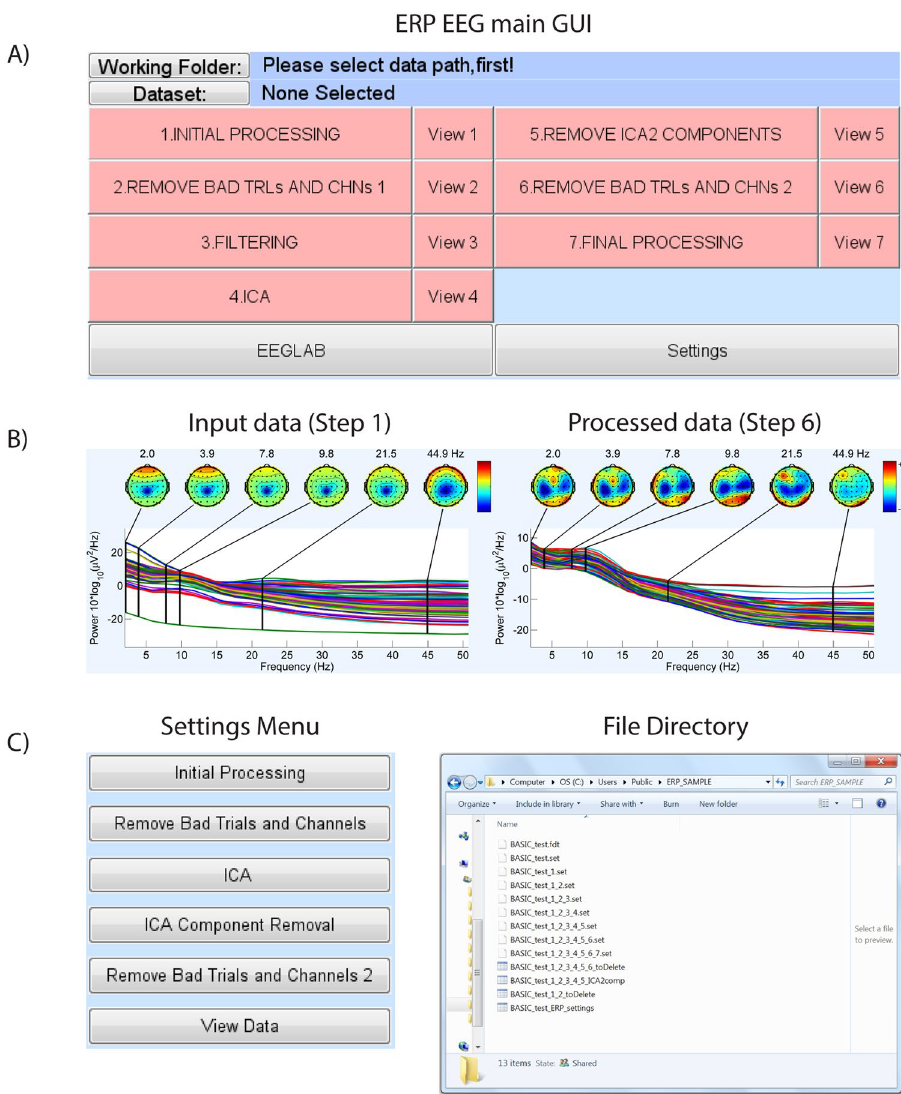
Figure 3. A Streamlined Toolbox for Multi-site EEG Data Processing and Archiving. ( A ) The main graphical user interface (GUI) of the ERPEEG toolbox, with 7 pre-processing steps. Through this main interface, users select the data (by clicking on Working Folder, and Dataset), and navigate through each preprocessing step. Clicking on a processing step opens a new GUI associated with that step, or runs that processing step. Steps that are completed turn green, and uncompleted steps remain red. ( B ) The view button (corresponding to each step) provides a visual summary of data cleaning processing (e.g., plots the power spectrum). This enables monitoring of data cleaning progress or detecting any major errors and data distortions. ( C ) The setting tab allows for selection of user-defined parameters for each step. ( D ) All intermediate steps (files created in completion of each step) are saved in the working folder following a standardized naming